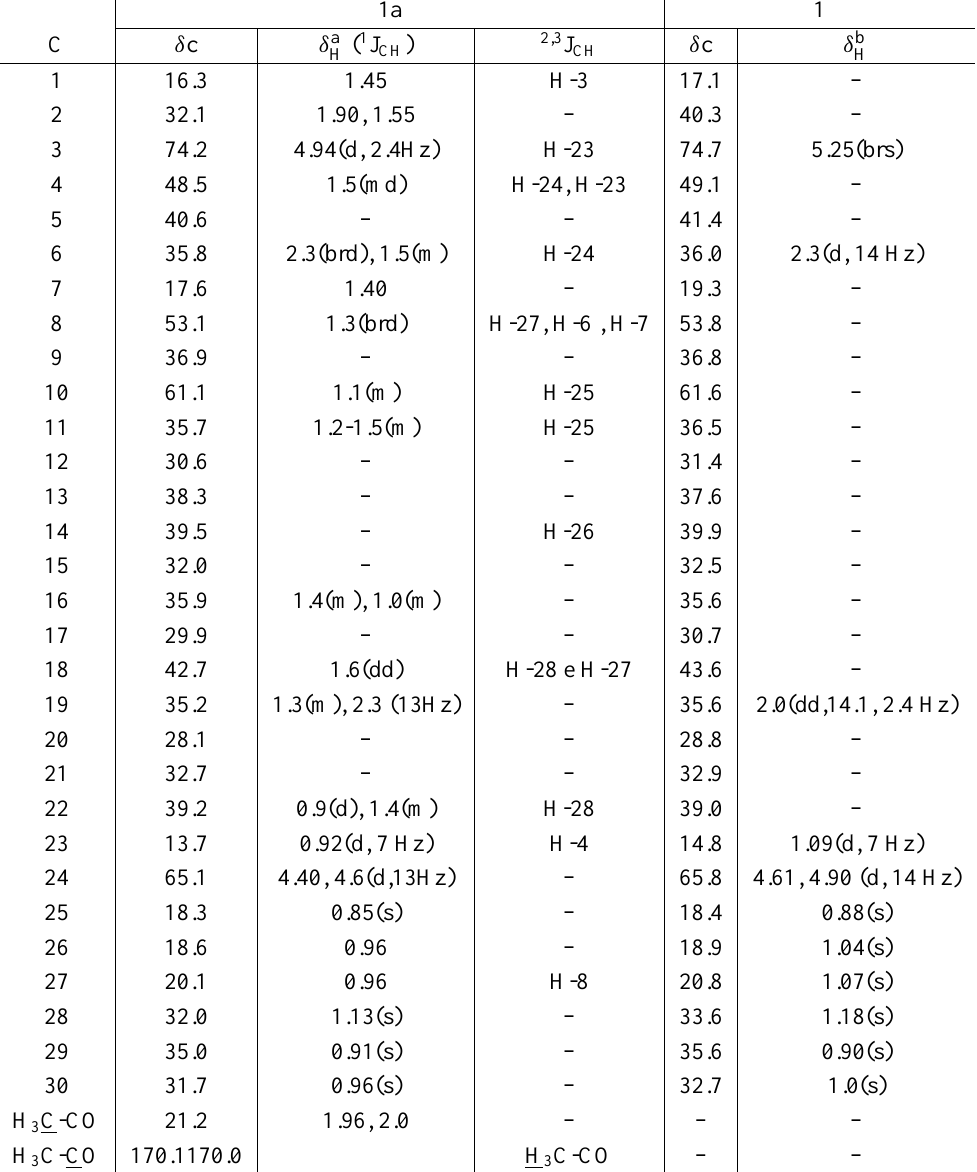
1 H and 13 C NMR data of the new triterpene (1, Pyridine-D